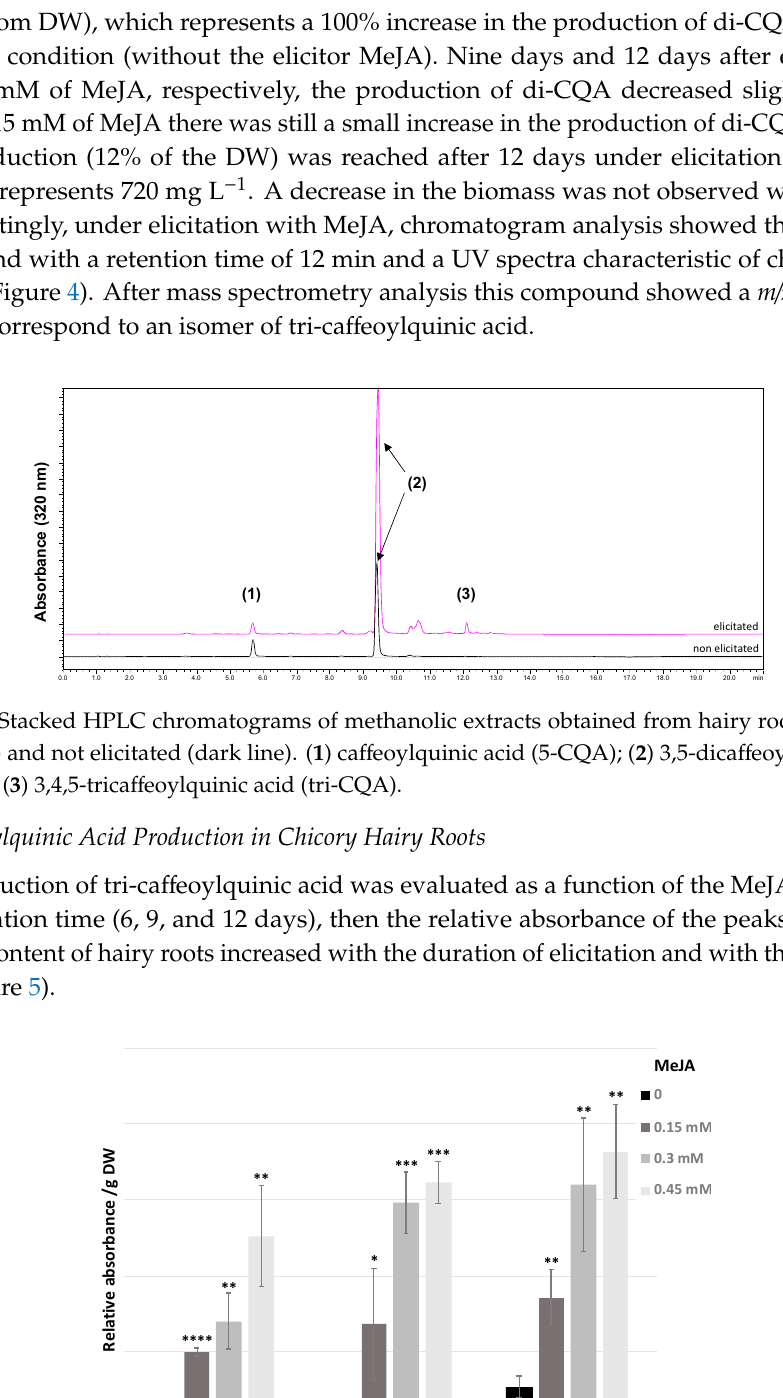
Figure 5. Effect of different concentrations of MeJA on the production of 3,4,5-tricaffeoylquinic acid (tri-CQA) in chicory hairy roots line. 0; 0.15; 0.3; 0.45 mM of MeJA indicates MeJA concentration of the culture medium. 6; 9; 12 days represents the duration of elicitation. DW: Dry weight. Statistics were achieved by a two-tailed t test using Prism GraphPad online tool (https://www.graphpad.com/ quickcalcs/ttest1/). The mean with SD were calculated and plotted. **** p < 0.0001; *** p = 0.0001 to 0.001; ** p = 0.001 to 0.01; * p = 0.01 to 0.05; NS (not significant), p ≥ 0.05. All the conditions were compared to control condition 0 mM MeJA.